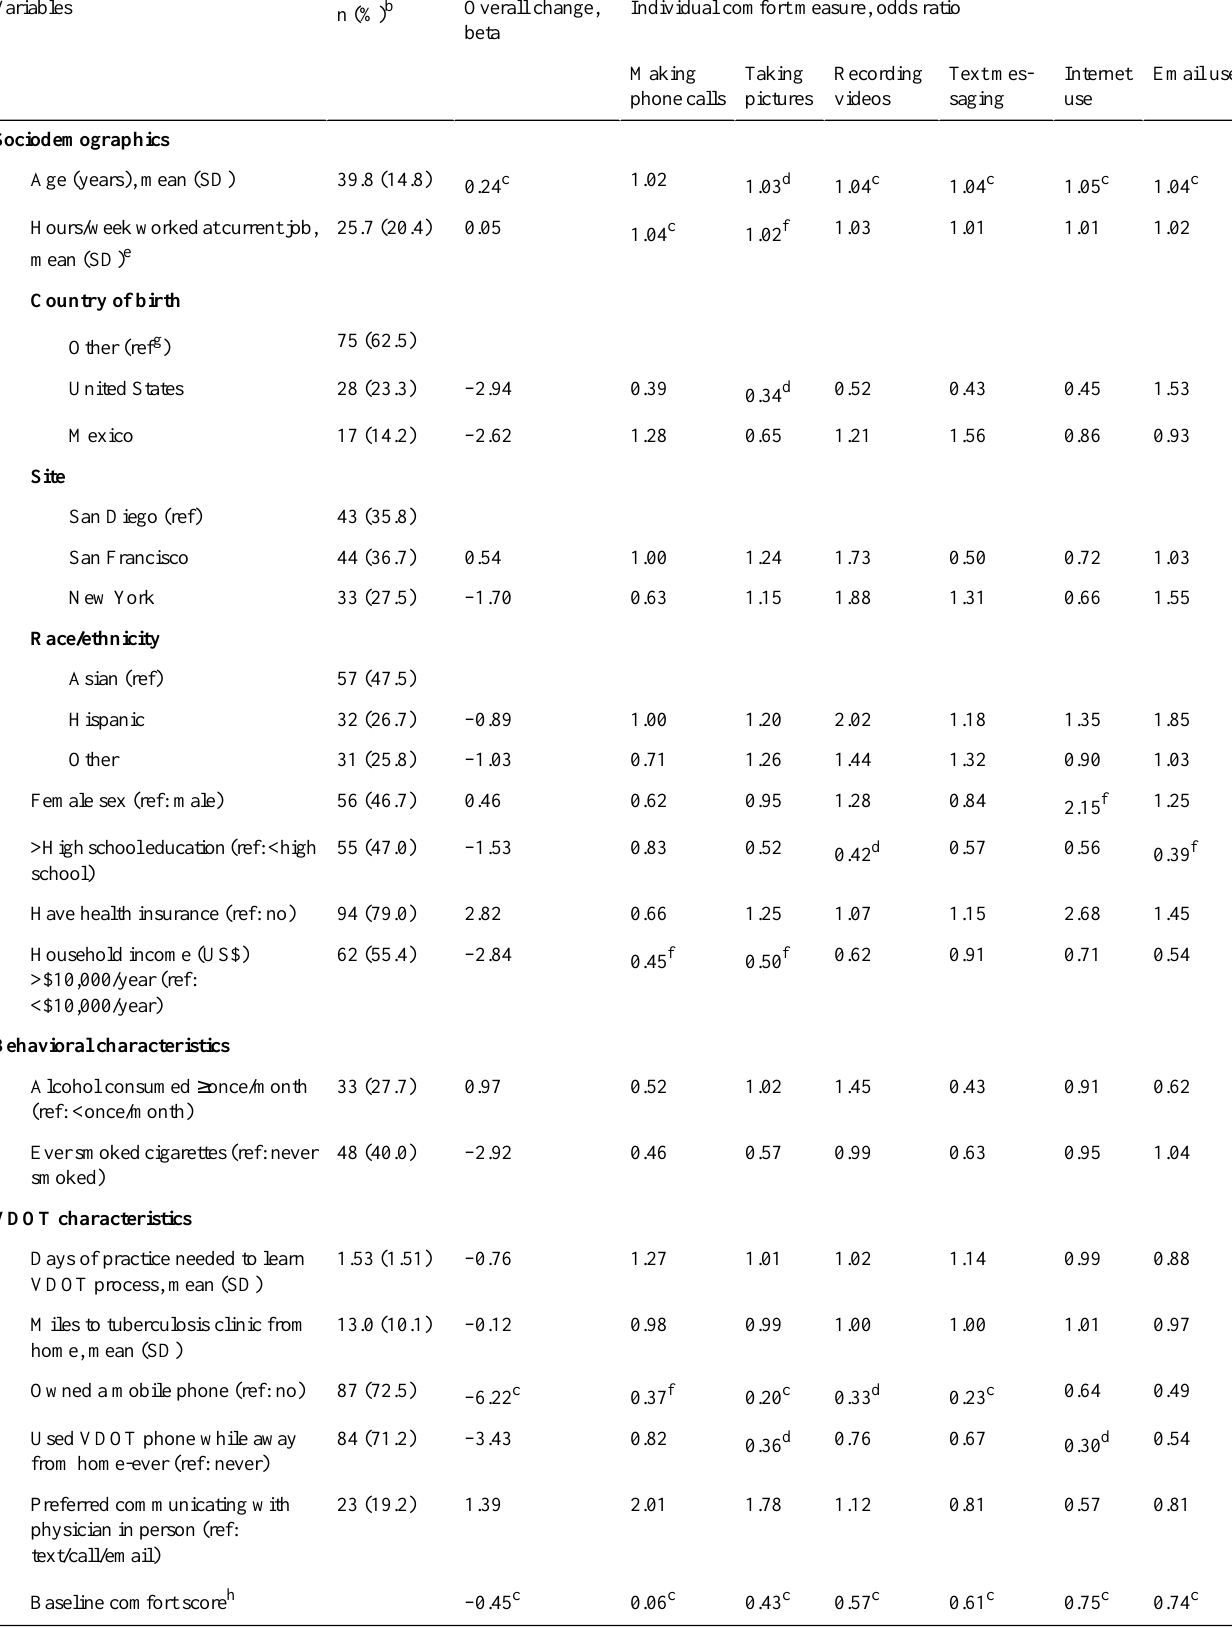
Table 2. Simple linear/logistic regression analysis a of change in comfort using mobile phone functions among Video Directly Observed Therapy (VDOT) study participants